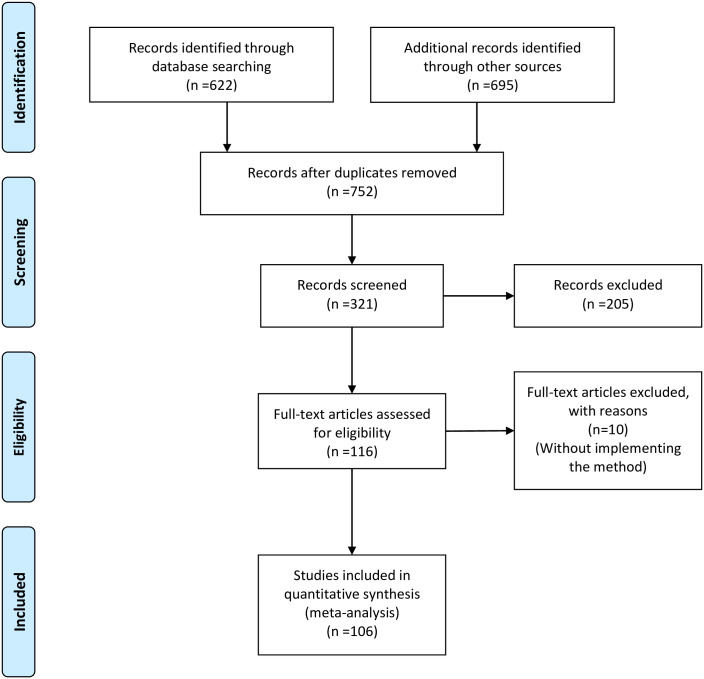
PRISMA flowchart.